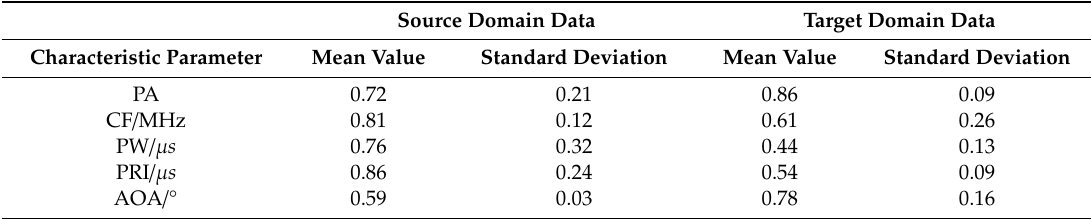
Table 3. Distribution di ff erence after normalization of the source domain data and the target domain